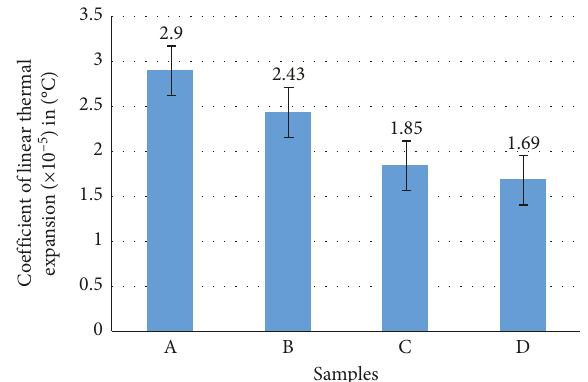
Figure 5: Coefficient of linear thermal expansion of basalt fiber